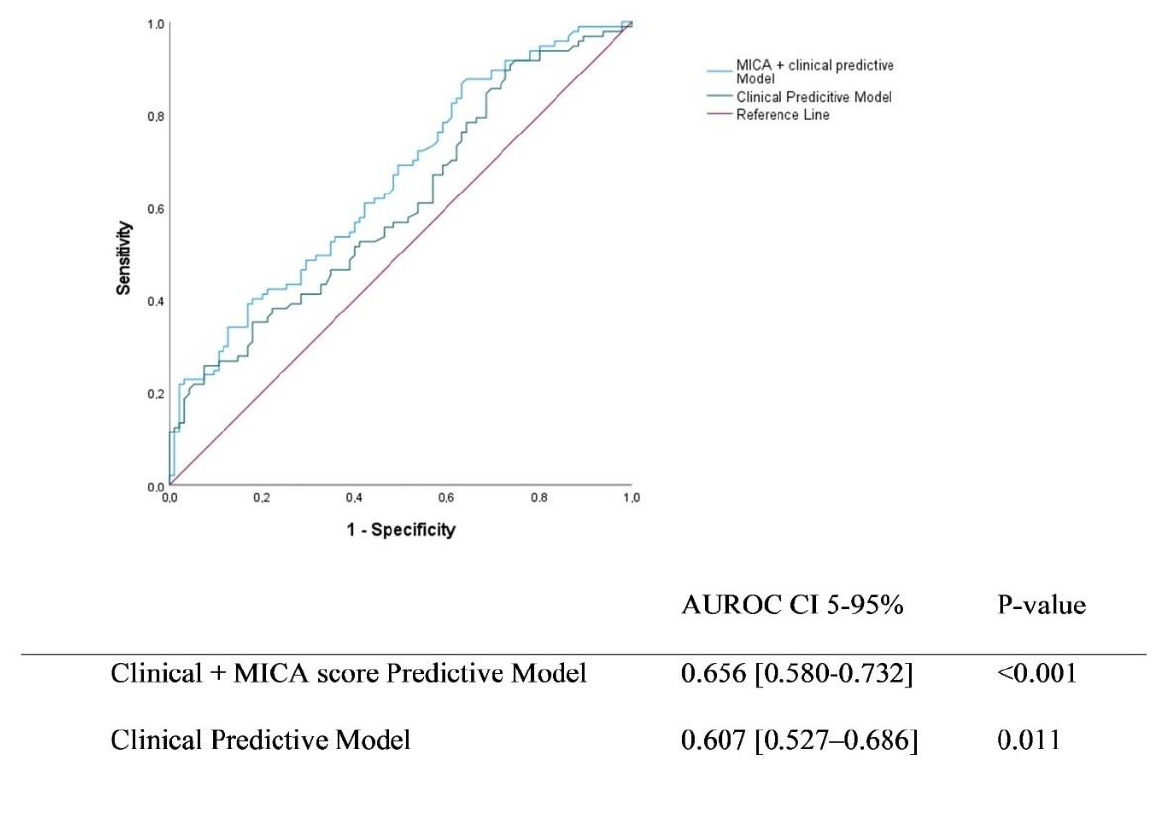
Figure 2. ROC curves of clinical and clinical plus MICA score models for symptomatic intraoperative neurological deficits. AUROC-area under the receiving operating characteristics; CI 5-95%: confidence interval 5%-95%; MICA- Myocardial Infarction and Cardiac Arrest Score; Pseudo-R2 = 0.204-clinical plus MICA score predictive model; Pseudo-R2 = 0.188-clinical predictive model.